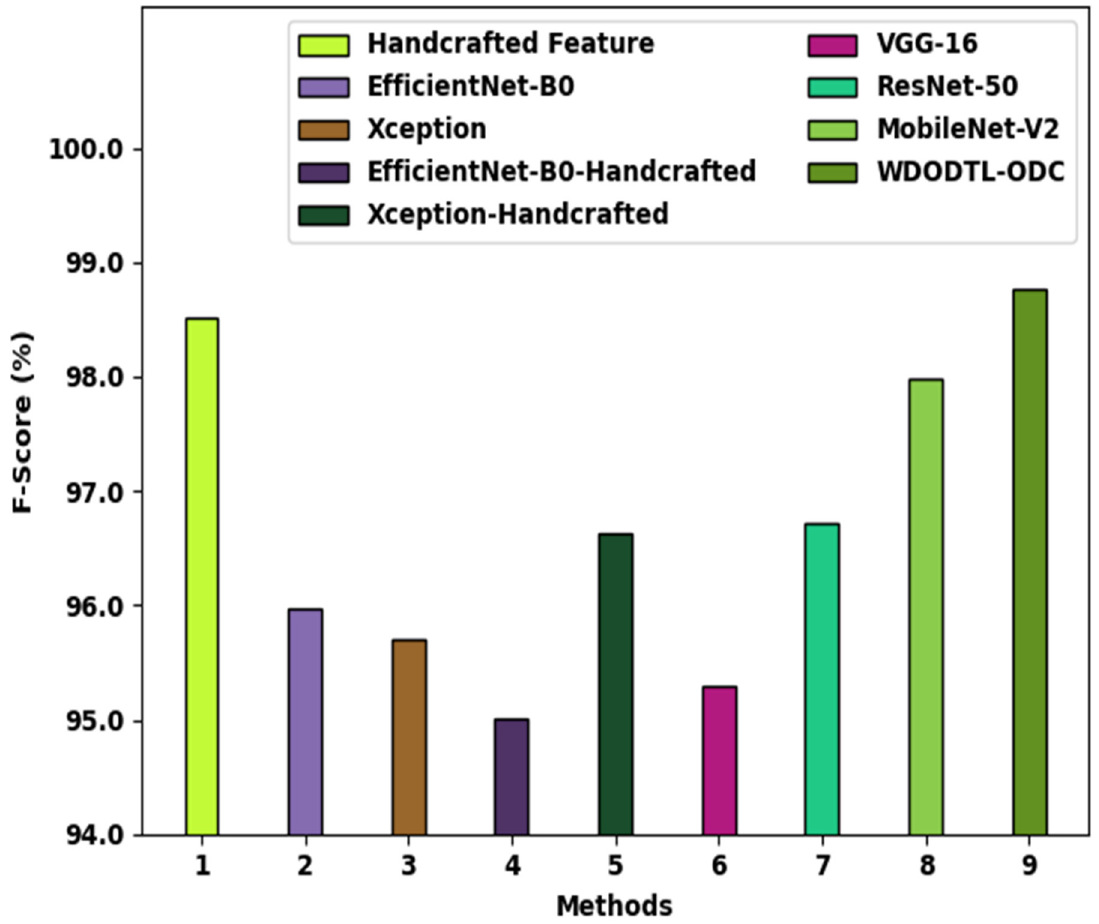
Figure 12. F score analysis of WDODTL-ODC approach with existing Figure 12. 𝐹 (cid:3046)(cid:3030)(cid:3042)(cid:3045)(cid:3032) analysis of WDODTL-ODC approach with existing algorithms.